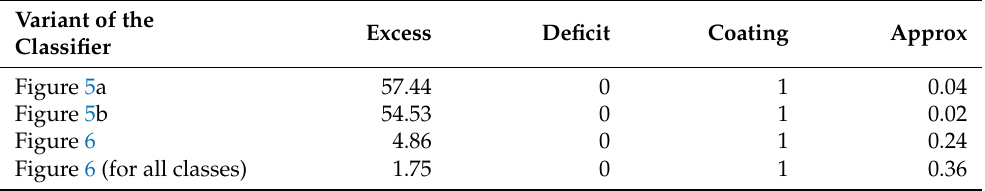
Table 4. EDCA Quality Characteristics for the Considered